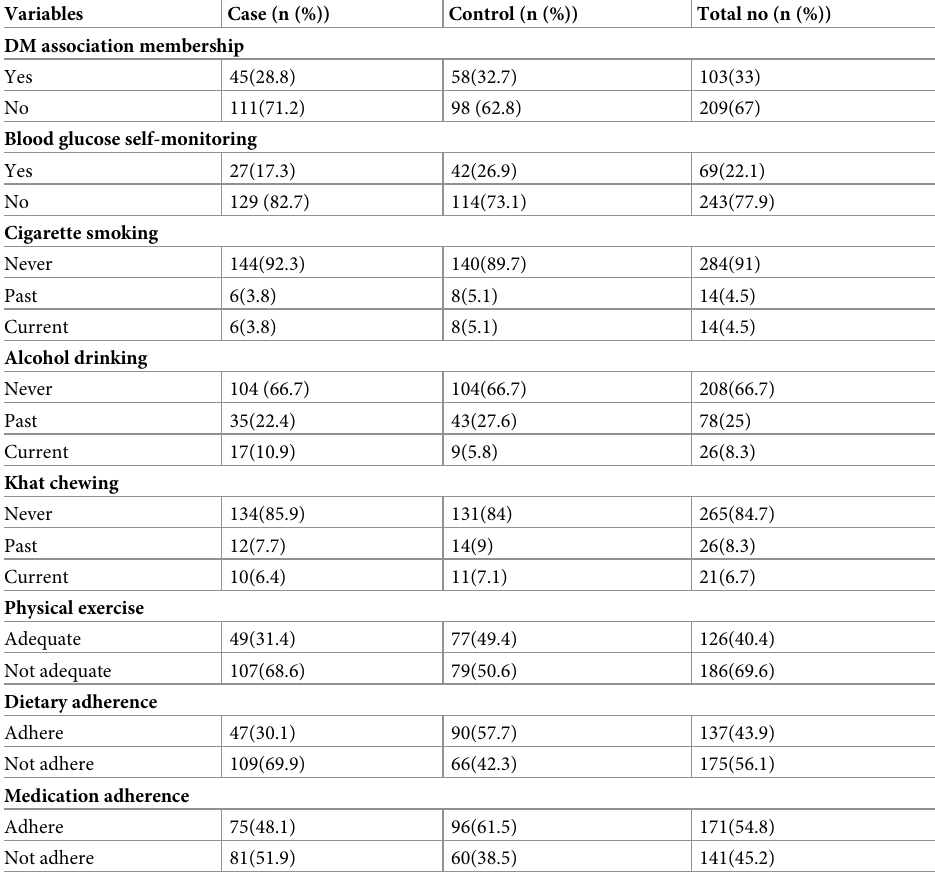
Table 3. Diabetes self-care activities of adult patients with type 2 diabetes mellitus on follow-up in a Diabetic clinic of Gamo and Gofa zone public hospitals, southern, Ethiopia,